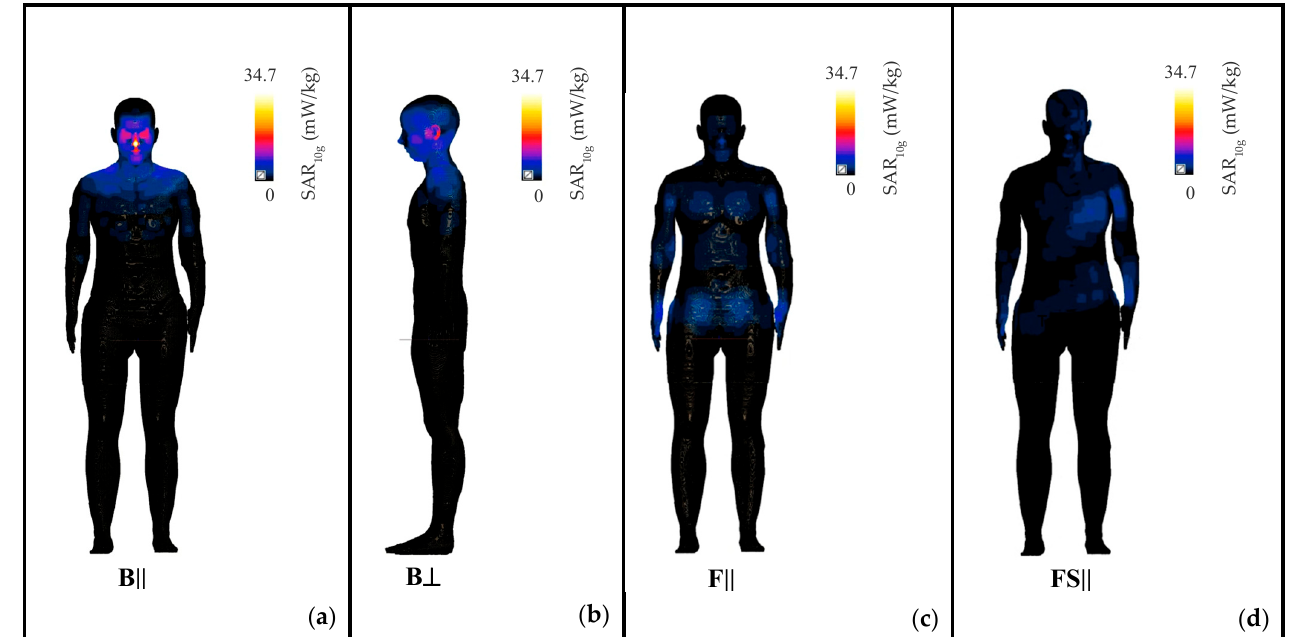
Figure 5. Distribution of the SAR 10g over the skin of the whole body in configurations B|| ( a ) and B ⊥ ( b ), which corresponded to the exposure scenario with the highest exposure level in the head region, and in configurations F|| ( c ) and FS|| ( d ), which corresponded to the exposure scenarios with the highest exposure level for the genital region. In all the cases, the SAR 10g was normalized to the maximum found in the worst case (i.e., in the B|| configuration), which was equal to 34.7 mW/kg.